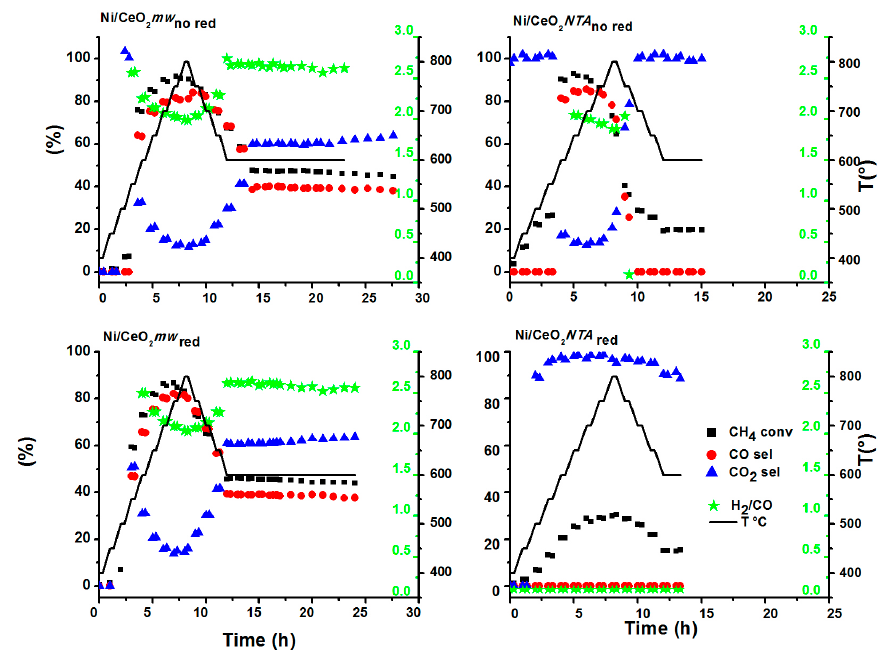
Figure 1. Influence of temperature and time on stream on CH 4 conversion and CO, CO 2 selectivities, and H 2 /CO ratio.